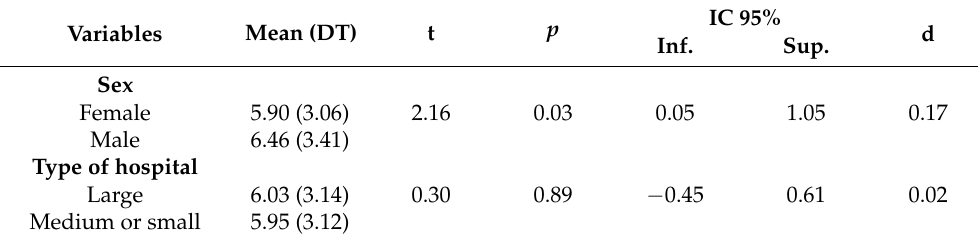
Table 2. T -test for personal lateral